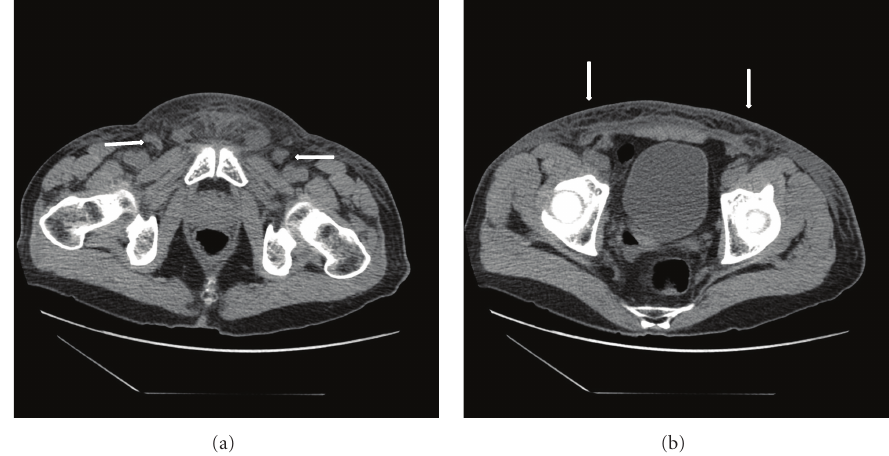
Figure 2: Computed tomography of abdomen and pelvis showing (a) extensive edema and stranding of subcutaneous tissue at the symphysis pubis and bilateral groin areas; bilateral enlargement of inguinal lymph nodes is also noted (two arrows). (b) Edema and fat stranding extending into subcutaneous tissue at anterior lower abdominal wall area (two